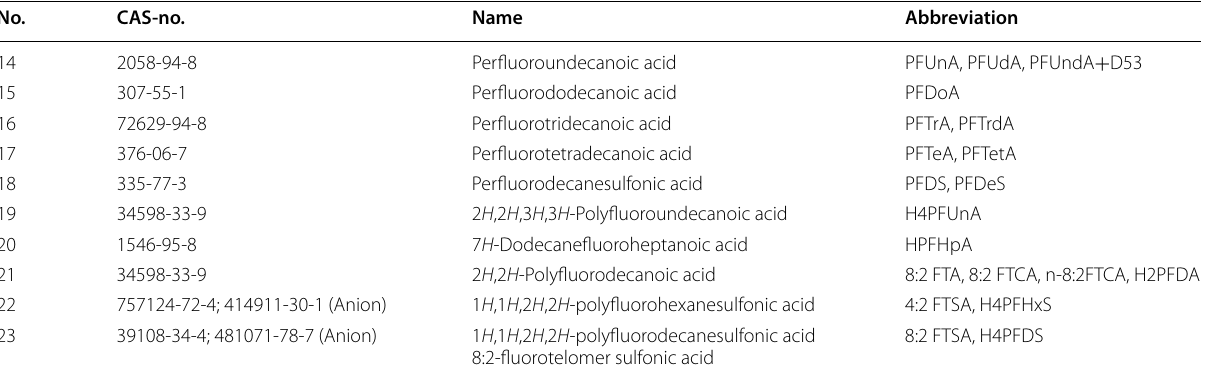
Table 3 Second priority PFC No.